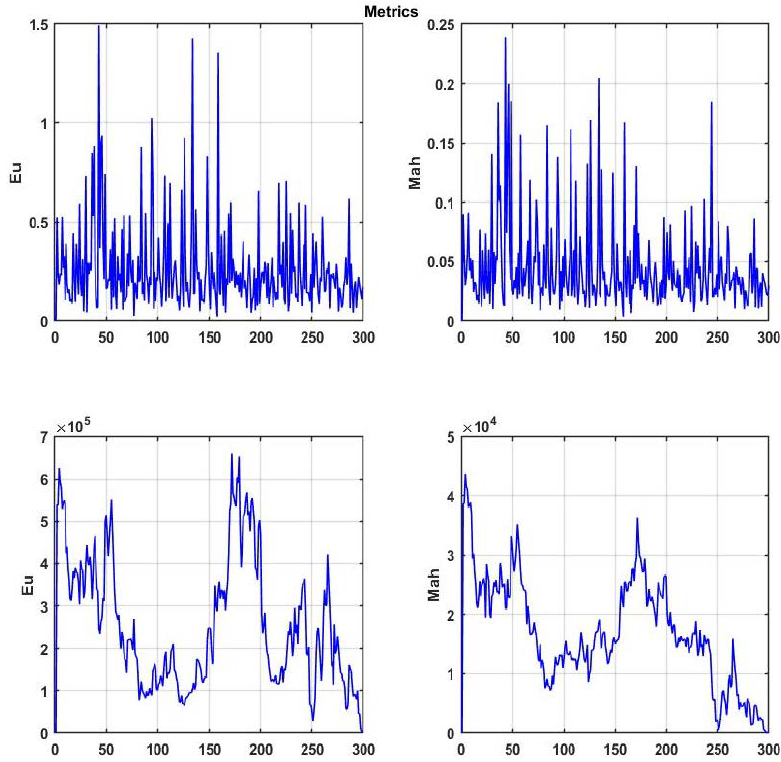
Figure 5. Changes in the Euclidean and Mahalanobis distances for a multidimensional chaotic process.